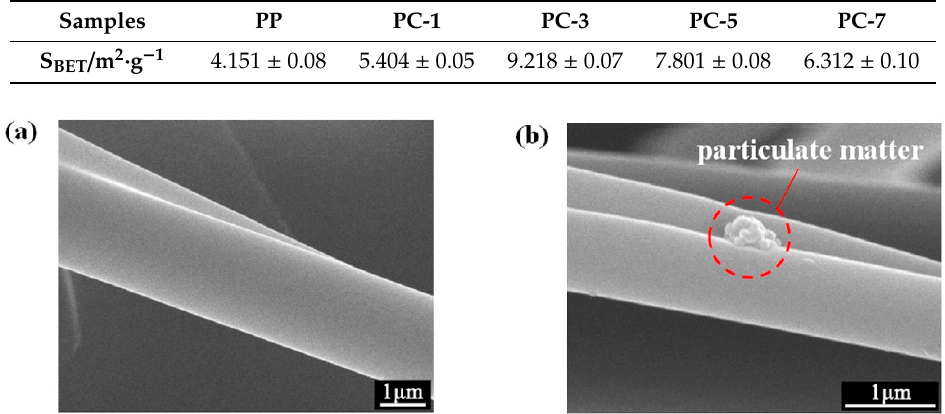
Table 6. Specific surface areas of the samples.